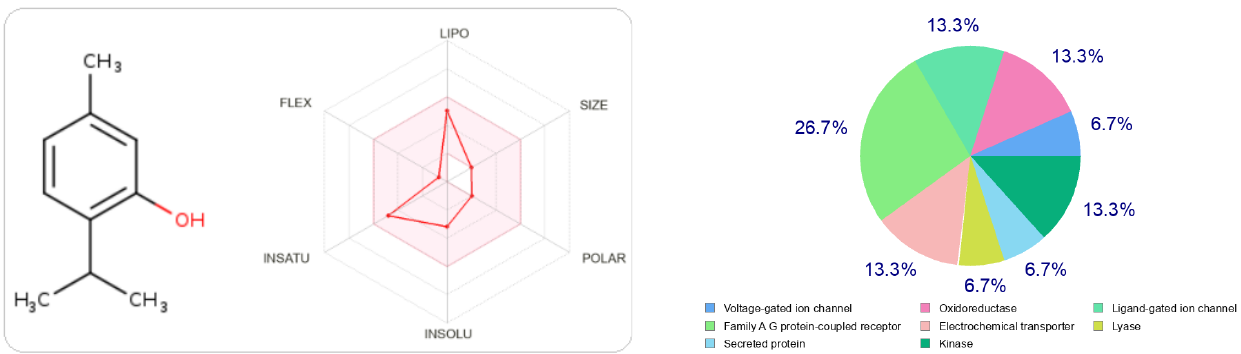
Figure 3. The radar of bioavailability allowing a drug resemblance of thymol and the probability percentages attached to each type of bioactive target.